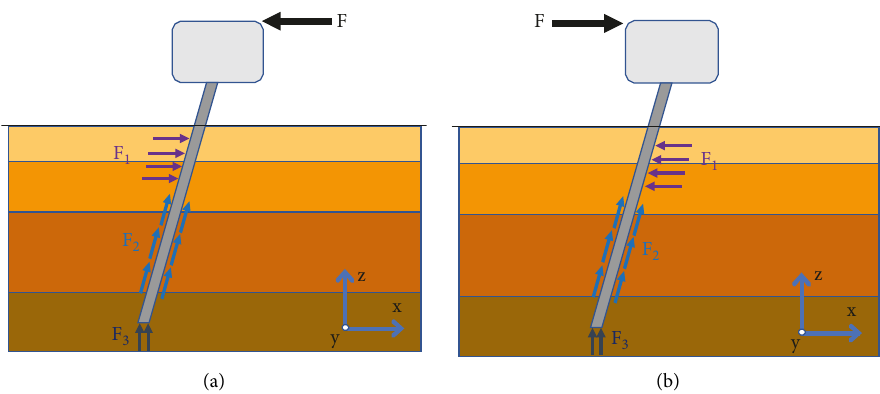
Figure 6: Schematic of inclined pile: (a) schematic of negative inclined pile; (b) schematic of positive inclined horizontal coordinate represents the amplitude of the downward pressure load. The red broken line, blue broken line, and black broken line represent the horizontal dis- placement of the positive inclined pile, negative inclined pile, and vertical pile, respectively. The horizontal displacement of the negative inclined pile is obviously smaller than that of the positive inclined pile and vertical pile, and the lateral bearing capacity of the negative inclined pile is better than that of the vertical pile and positive inclined pile. The vertical